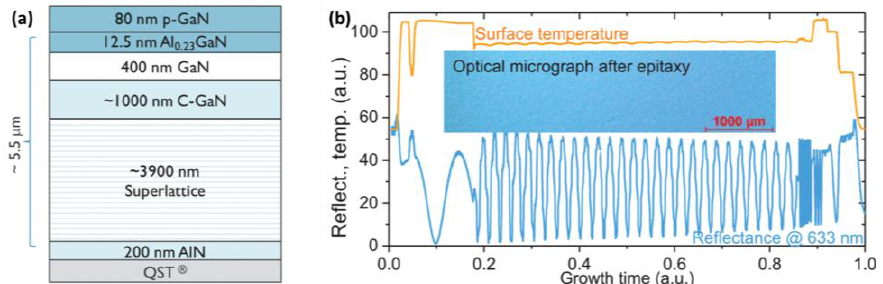
Figure 2. ( a ) Schematic cross-section of the epitaxial layer stack and ( b ) in-situ data of the surface temperature and the reflectance. The inset shows an optical micrograph of the surface after the epitaxial growth [128]. Figure reproduced with permission from IEEE Transactions on Semiconductor Manufacturing.